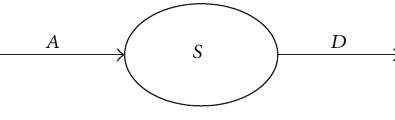
Figure 1: A simple